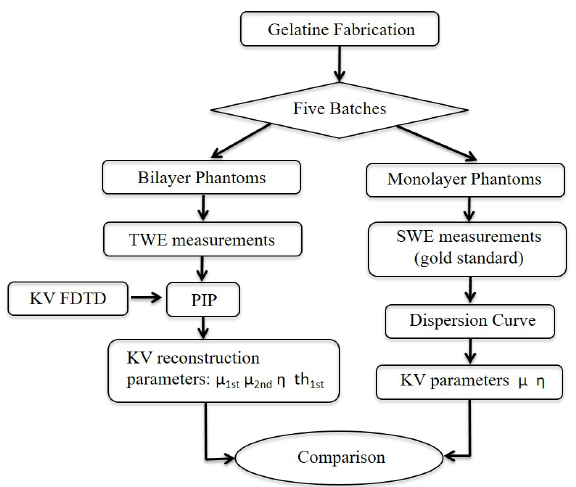
Figure 1. Schematic flowchart used for validating the KV viscoelastic model.